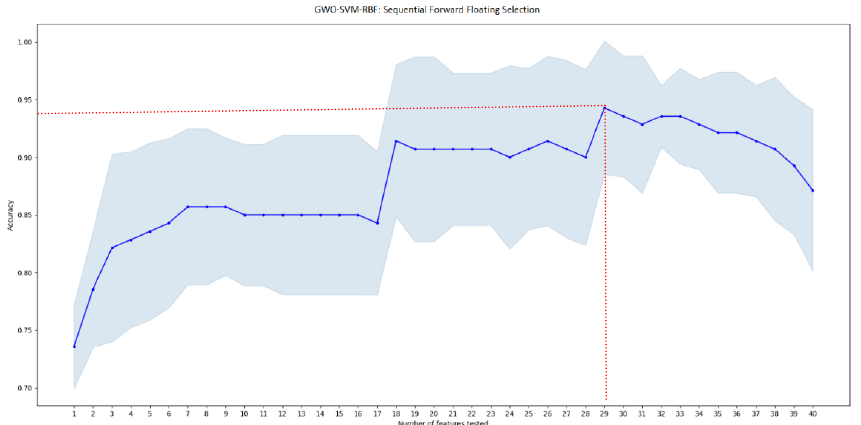
Figure 8. GWO-SVM classification accuracy score according to the sub-vector of tested features using SFFS algorithm. Red lines indicate the best performance